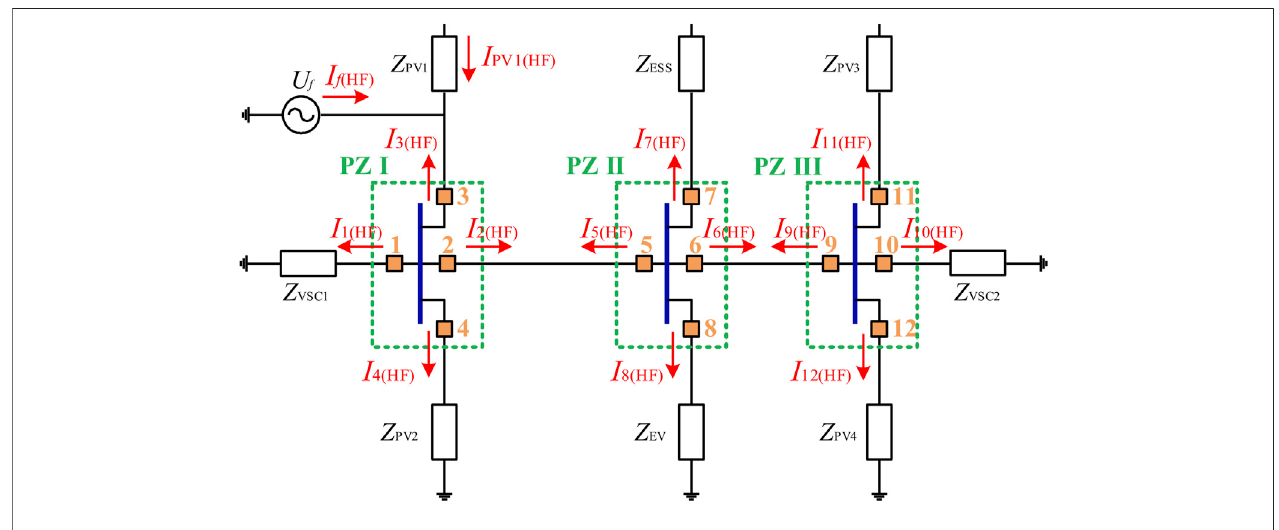
FIGURE 3 | Super-imposed network with fault